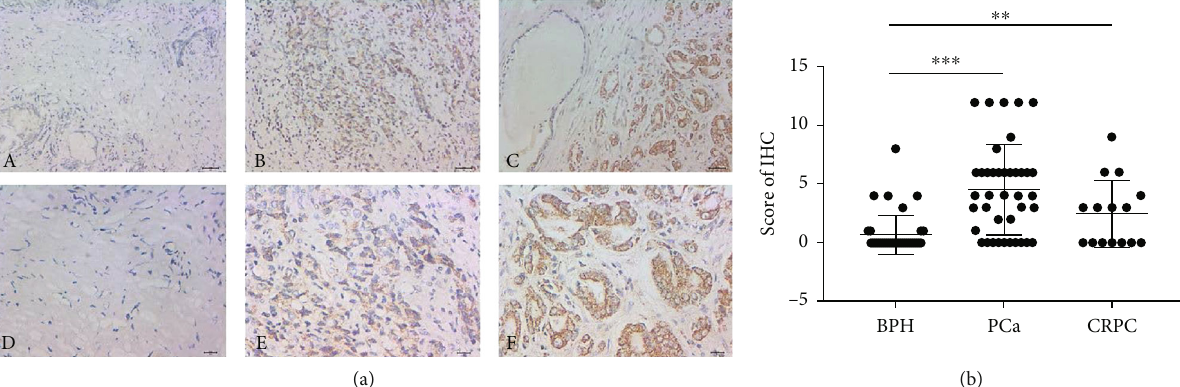
Figure 1: Immunohistochemical staining of MUS81 in BPH, PCa, and CRPC tissues. (a) IHC analysis of MUS81 in BPH (A and D), PCa (B and E), and CRPC (C and F) tissues. (b) Scores of IHC and analysis of MUS81 expression in BPH, PCa, and CRPC tissues. ∗∗ P < 0 : 01 and ∗∗∗ P < 0 : 001 , versus the expression of MUS81 in BPH.